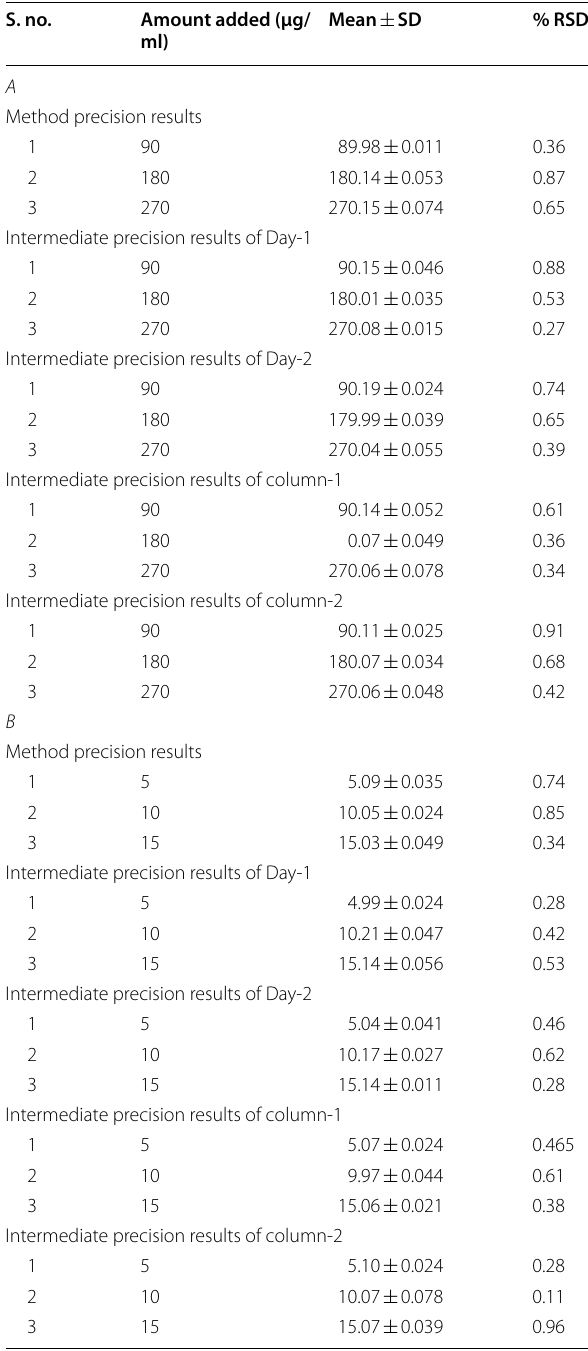
Table 4 UPLC precision results of (A) Bempedoic acid and (B) Ezetimibe